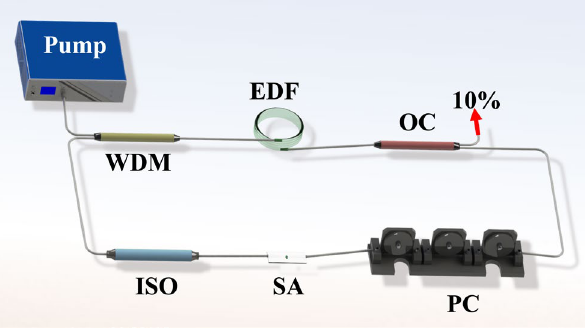
7 of 13 Table 2. Summary of β and I s values for various different NLO materials. λ